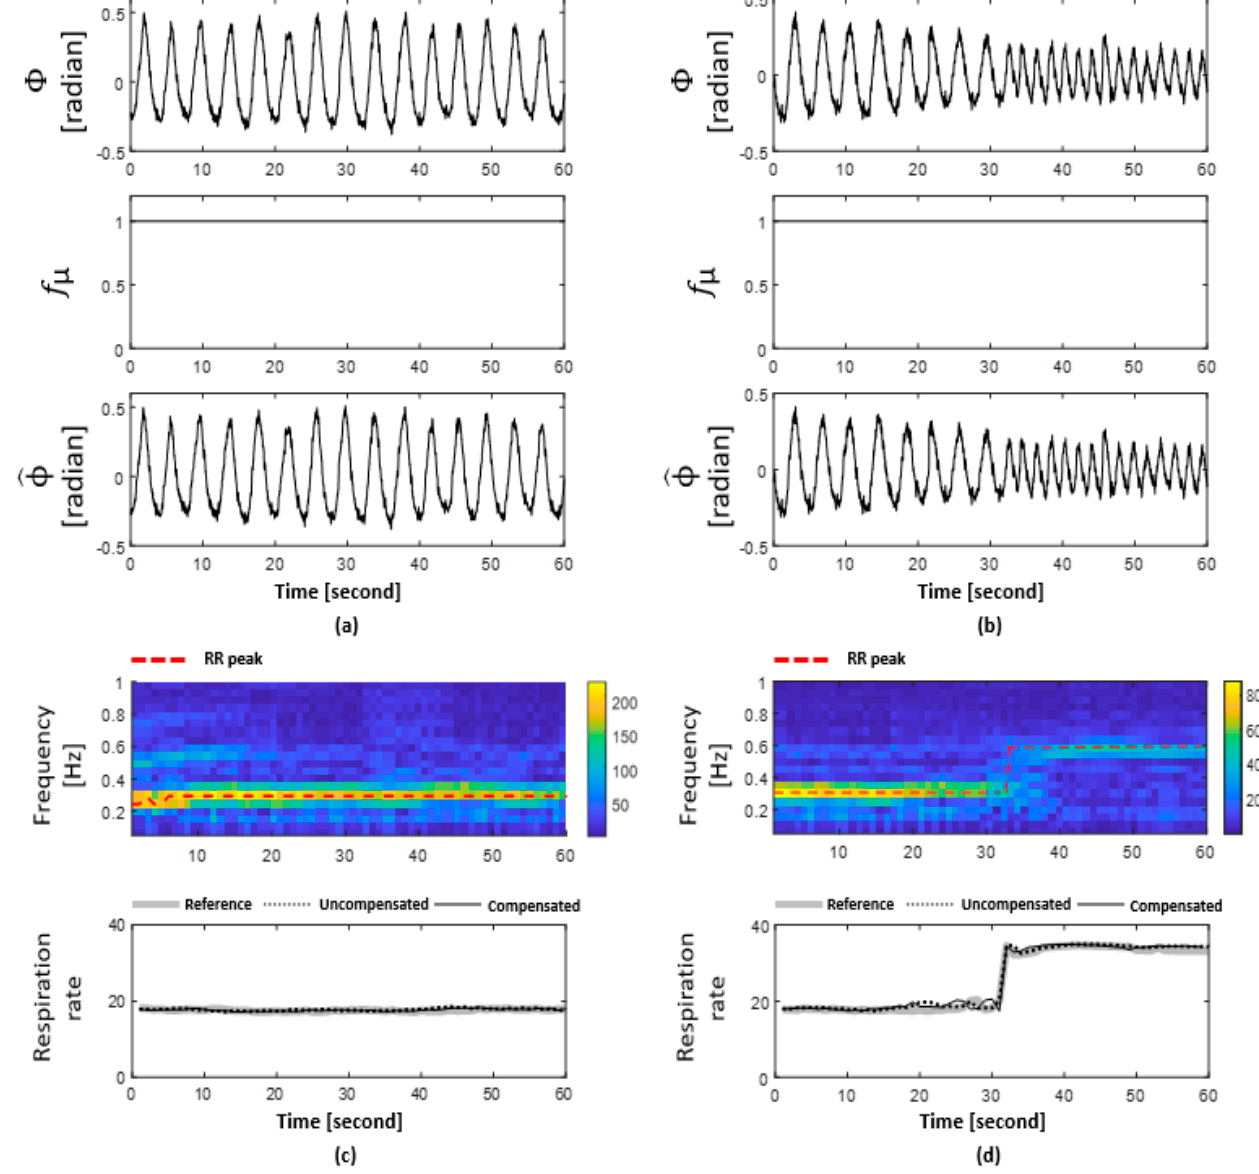
Figure 8. Compensated respiration estimation and comparison in situations where the driver is motionless. ( a , c ) Respiration compensation in straight driving, ( b , d ) respiration compensation in straight driving with faster breathing after 30 s.